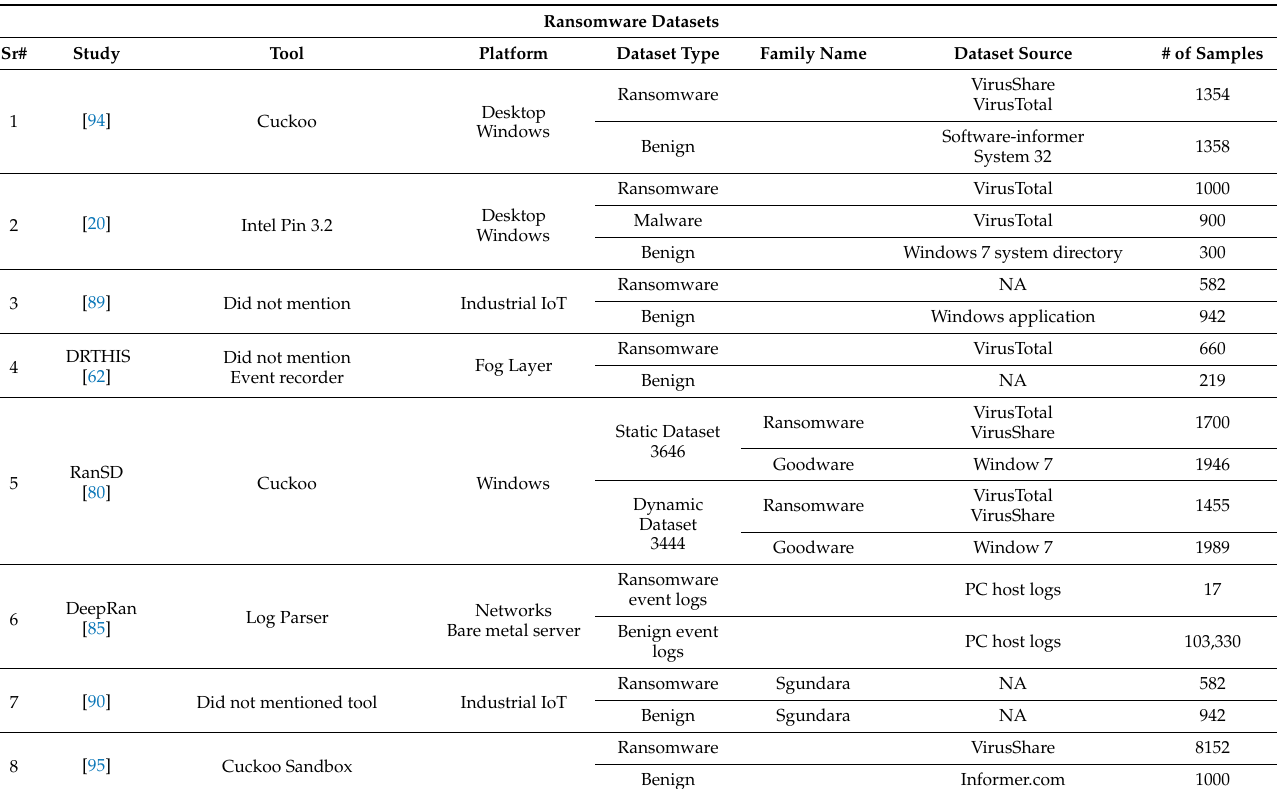
Table 3. Datasets used in ransomware detection